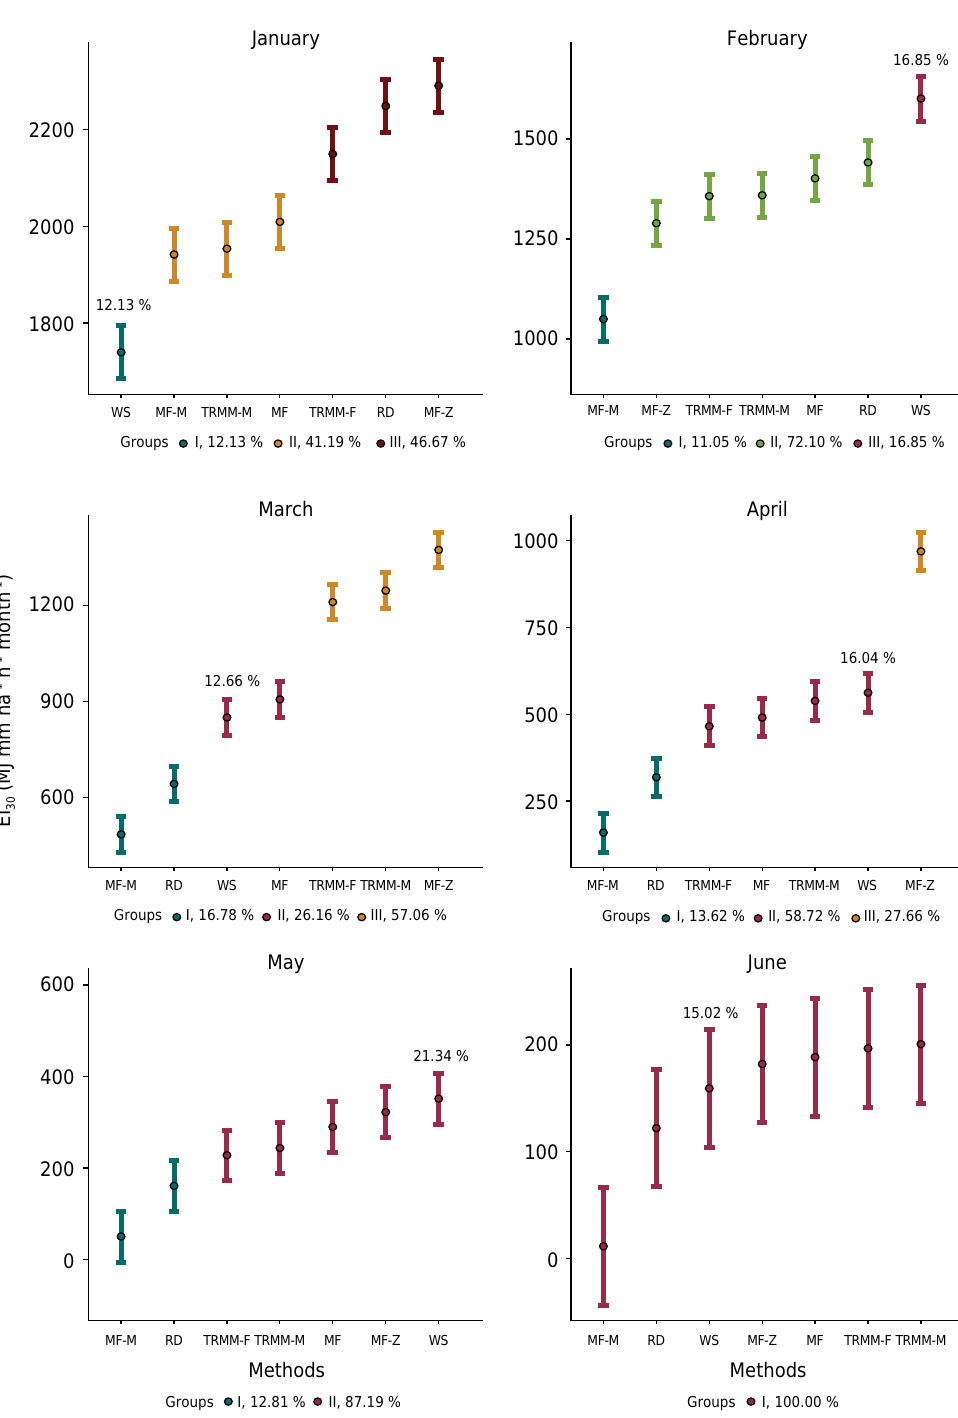
Figure 5. The univariate grouping of methods of estimation of the monthly rainfall erosivity indexes (January to June), by Scott and Knott (1974), with a Chi-squared significance level of 5 %. The blue color refers to the standard method (WS), the shades of green or red were attributed to the methods that underestimate or overestimate the rainfall erosivity,